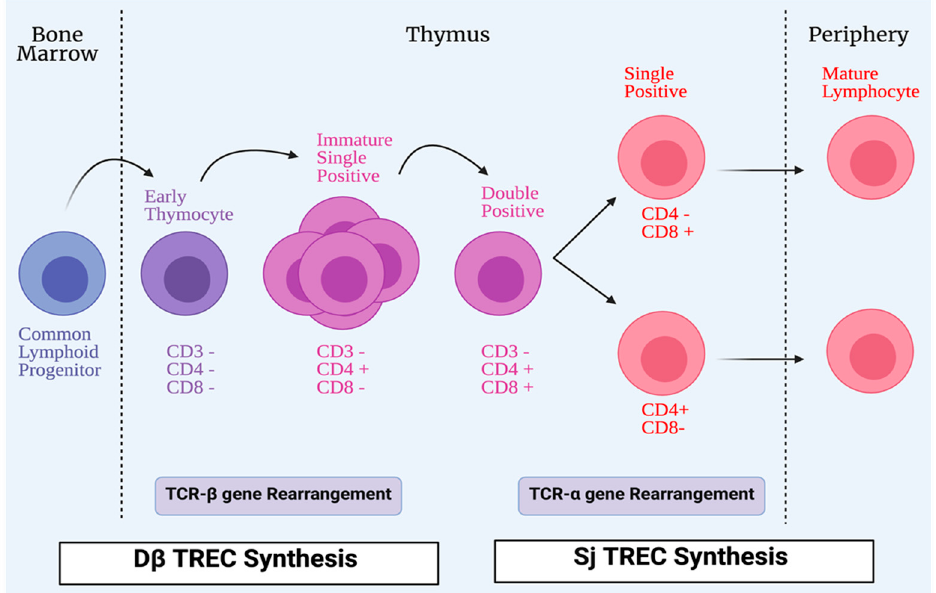
Figure 2. Process of T-cell maturation. All conventional T-cells start life as lymphoid progenitors, which migrate from the bone marrow to the thymus to initiate proliferation and maturation. In the thymus, early thymocytes lack the expression of CD4 and CD8 co-receptors that are involved in T-cells receptor (TCR) signaling. The TCR, which has two chains, is formed by a process of TCR- β gene rearrangement. Early thymocytes then develop CD4+CD8+ (double positive), and during that time the TCR- α chain develops. CD4+CD8+ (double positive) cells differentiate into single positive cells, either CD4+CD8- or CD4-CD8+ to be exported as mature lymphocytes from the thymus to the periphery. During TCR rearrangements, some DNA small circles are formed in T-cells during their passage in the thymus; they are called T-cell receptor excision circles (TRECs). D β TRECs are synthesized during TCR- β rearrangement, whereas sj TRECs are synthesized during TCR- α